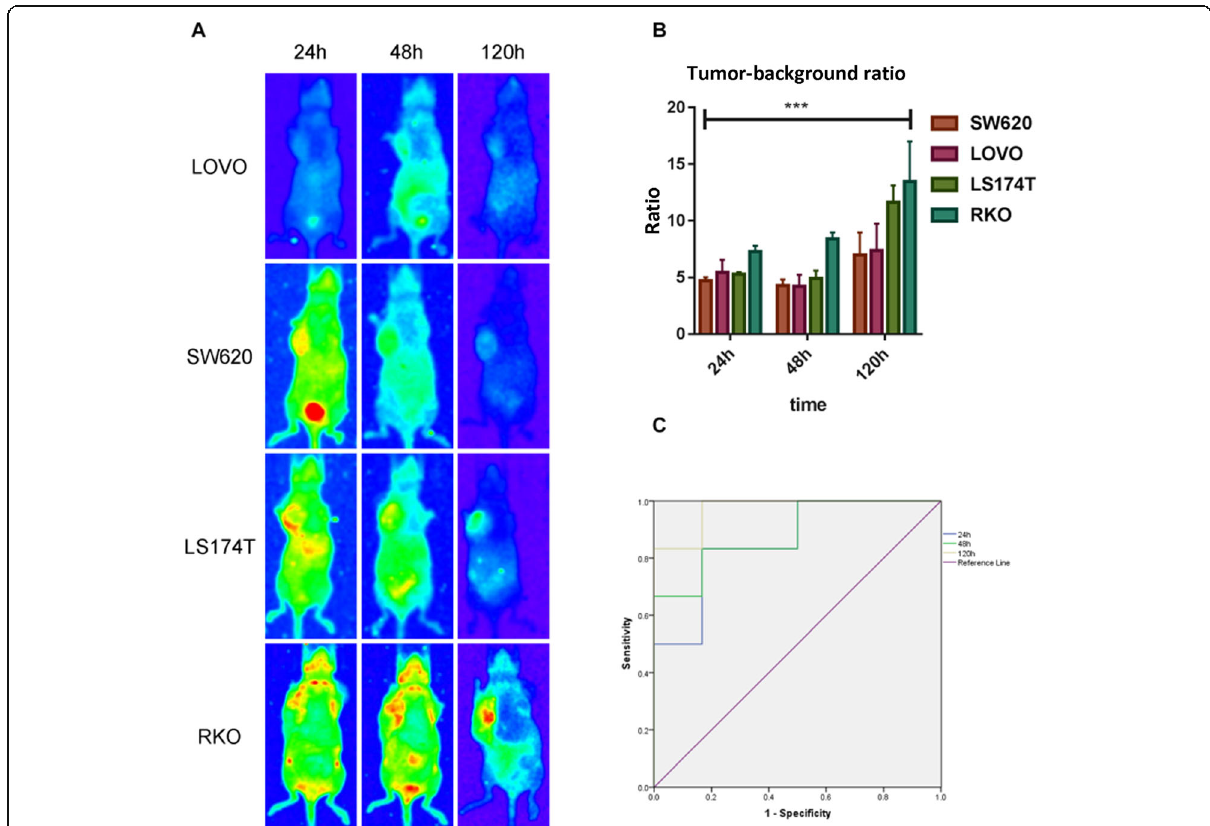
Fig. 7 PD-L1-specific CLI at different time points in human CRC xenograft models with 131 I-labeled PD-L1 antibody. a Cerenkov images of nude mice bearing four different CRC cell lines at 24 h, 48 h, and 120 h. b After injection of 131 I-PD-L1-Mab (37 MBq), the areas of interest were delineated along the tumor margin at 24 h, 48 h, and 120 h to quantitatively measure the Cerenkov fluorescence intensity of the tumor-to- background ratio. c The diagnostic effectiveness of Cerenkov images was tested by receiver operating characteristic curves. The data are expressed as means ± SD, *** p <